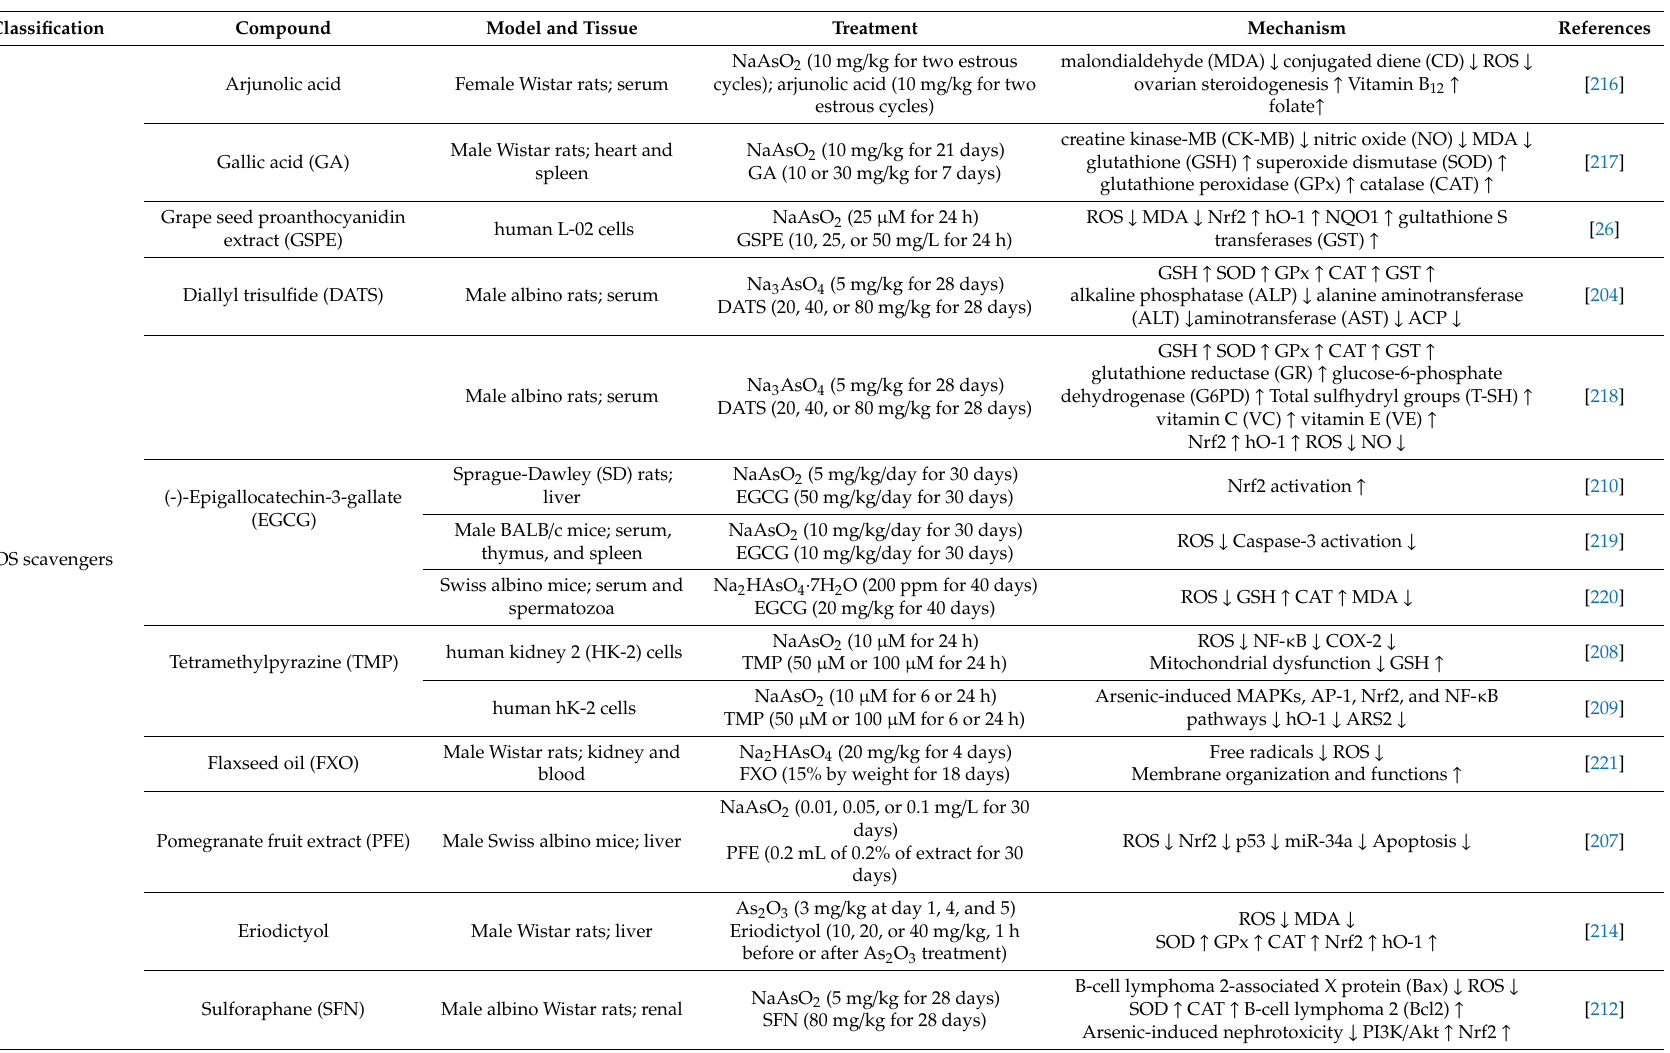
Table 2. Antioxidants with prophylactic and therapeutic potential to rescue arsenic